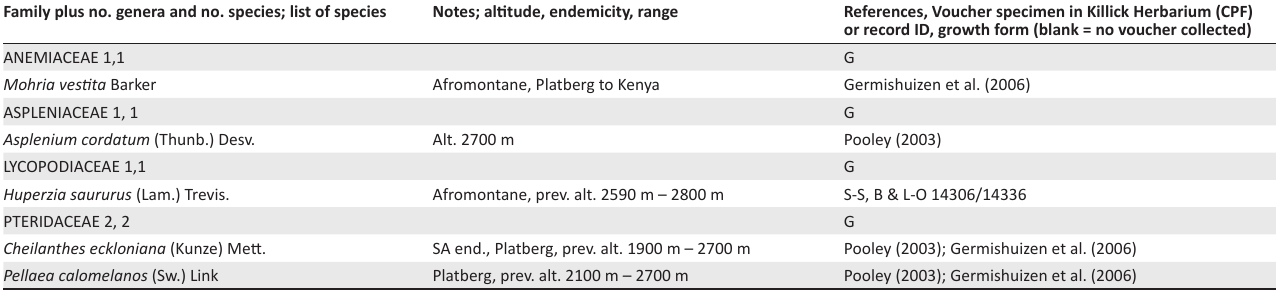
TABLE 1-A1: Pteridophyta – Four families, five genera, five species, zero endemics or near endemics. Family plus no. genera and no. species; list of species Notes; altitude, endemicity,